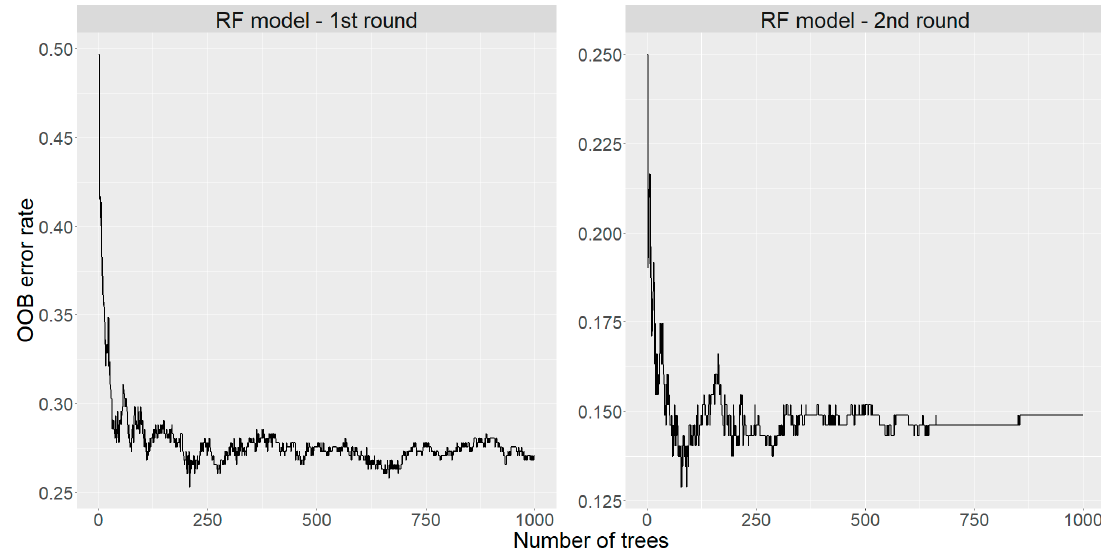
Figure 6. The relationship between OOB error rate and ntree in the RF models for extracting land use function regions.